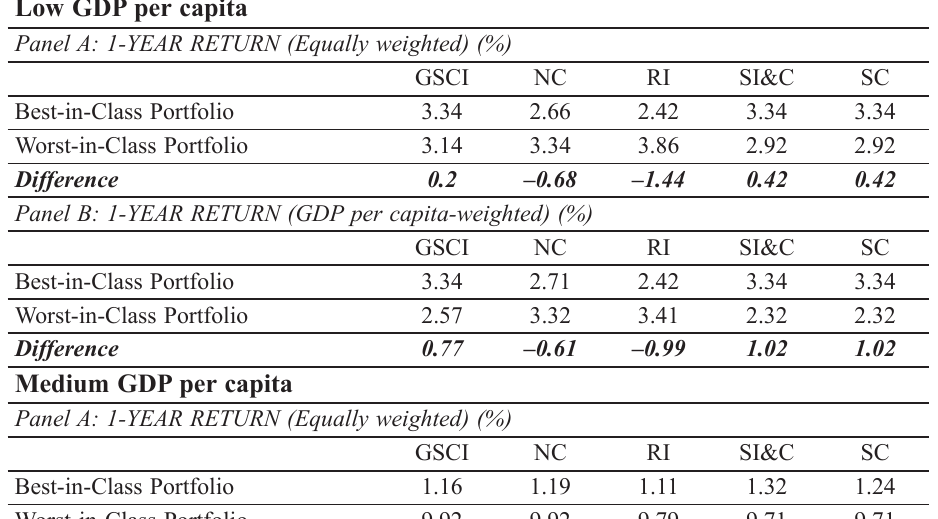
Table 5. 1-Year return for best-in-class and worst-in-class portfolios Low GDP per